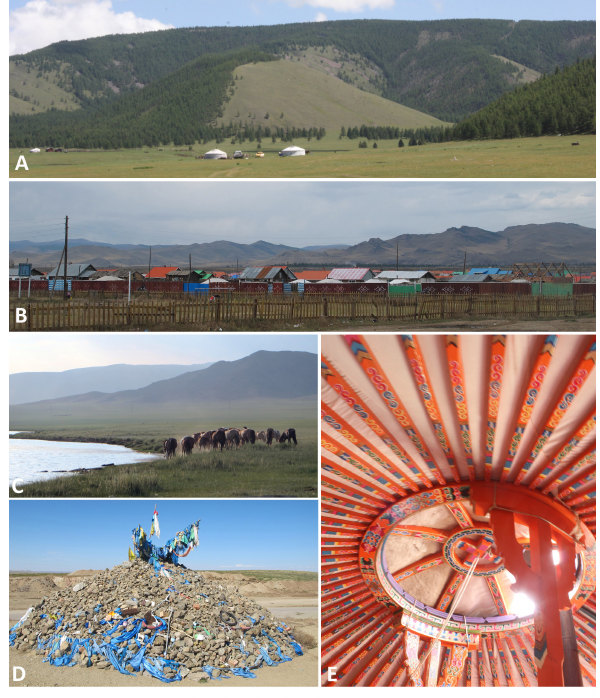
Fig. 1 . Continuity and change in the Mongolian pastoralist context: Culturally significant sites at different spatial scales (from the landscape level to the microscale within people’s homes [ gers ]) reflecting biocultural change. (A) the location of the ger homestead is carefully chosen according to livestock needs and cultural significance; (B) changes to a more sedentary lifestyle can affect cultural traditions, for example, limiting access to culturally significant sites; (C) certain landscape features, such as lakes, hold both cultural and livelihood significance; (D) an ovoo (rock cairn) signifies a landmark of cultural value; traditionally shrines are also built in more remote locations of ritual or mythical value, such as secret valleys and forests, but are not shown here because of cultural sensitivities; and (E) the inner ger architecture and arrangement holds cultural significance. Photo credits: A, C: B. Seele; B, D, E: H.